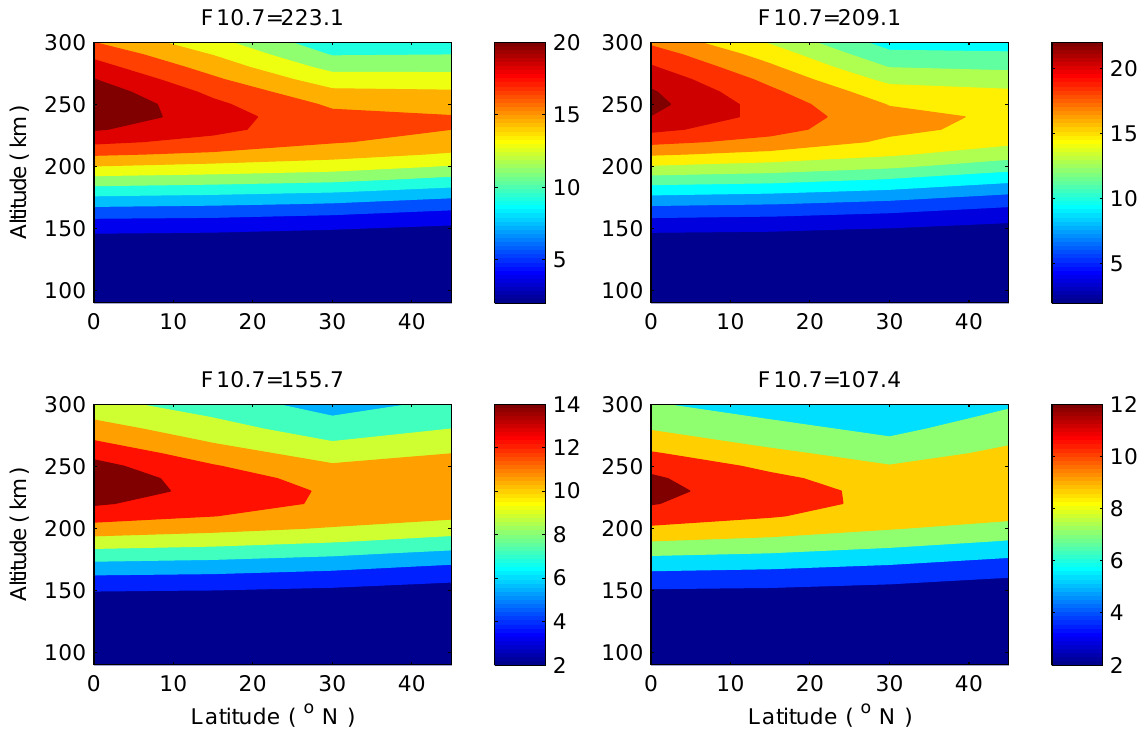
Fig. 6. Modeled morphology of 7320 ˚A between 0 ◦ and 45 ◦ N on 3 April for different solar activity levels at 14:00h local